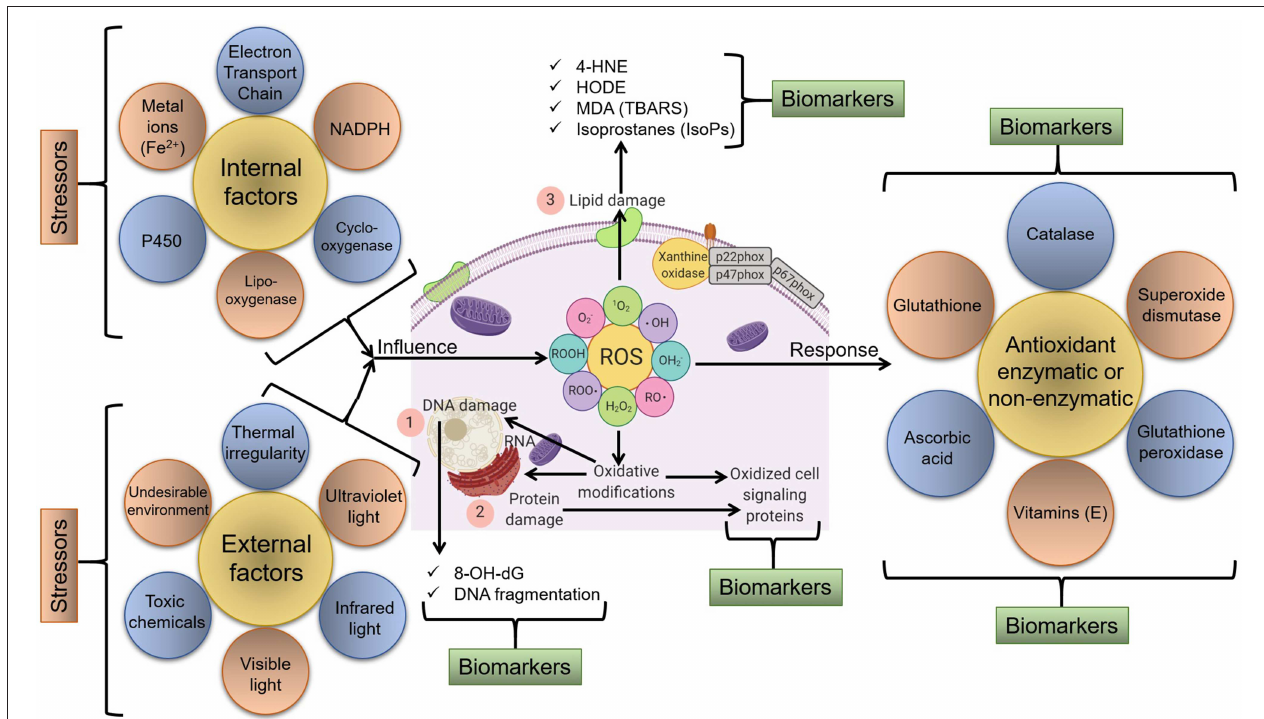
FIGURE 1 | Schematic representation of various endogenous and exogenous factors that act as stressors and lead to the generation of ROS and oxidative stress/modification. In response, various molecular and cellular redox-sensitive processes start that can be tracked as biomarkers of oxidative stress. For instance, major biomarkers include (1) markers of DNA/RNA damage/oxidation, (2) markers of protein damage/oxidation, and (3) markers of lipid damage via the oxidation of membrane components and available lipids,